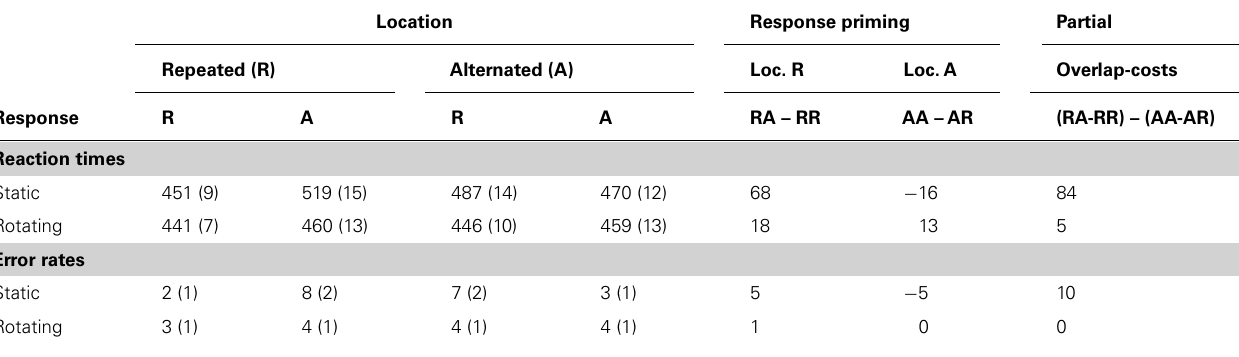
Table 1B | Experiment 1, response-priming and Event-file results.